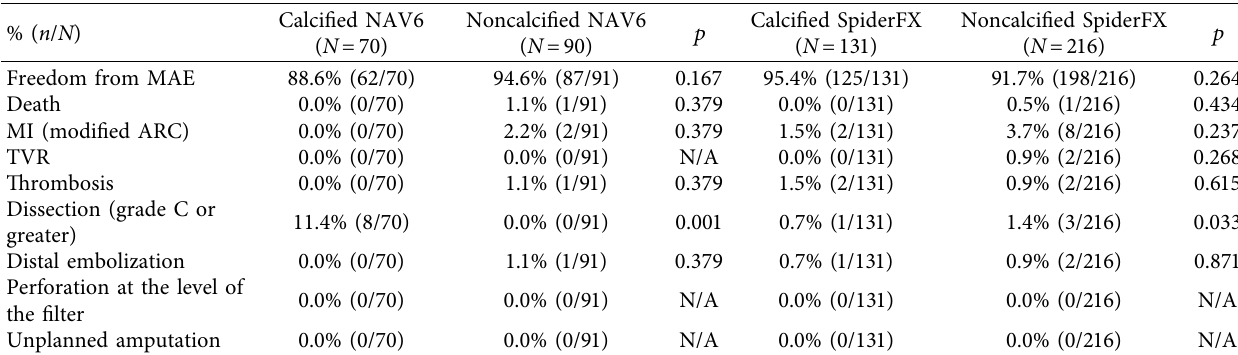
Table 5: Subset analysis of event rates by calcified lesions in the Emboshield NAV6 group.